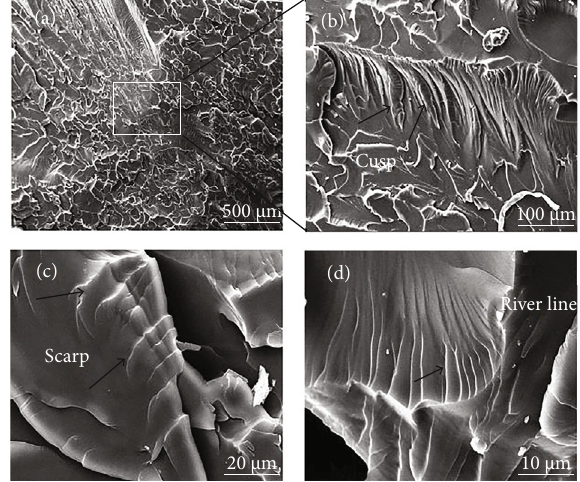
Figure 7: Micrograph images of epoxy sample fractured at 25 ° C creep